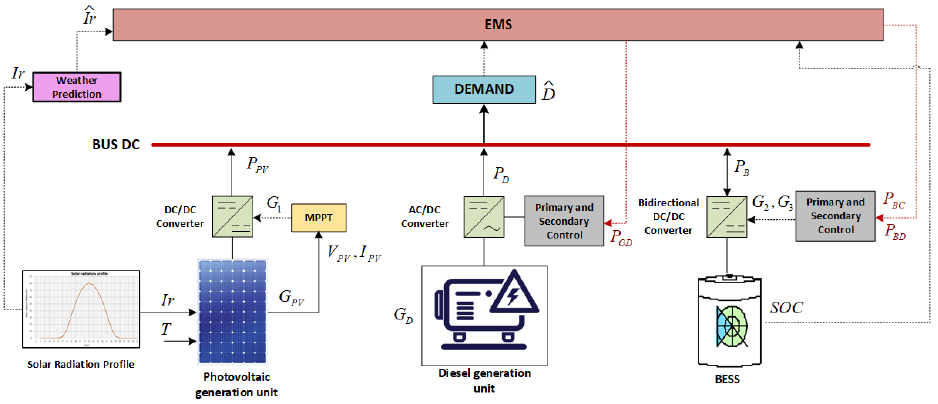
Figure 1. DC Microgrid configuration diagram.